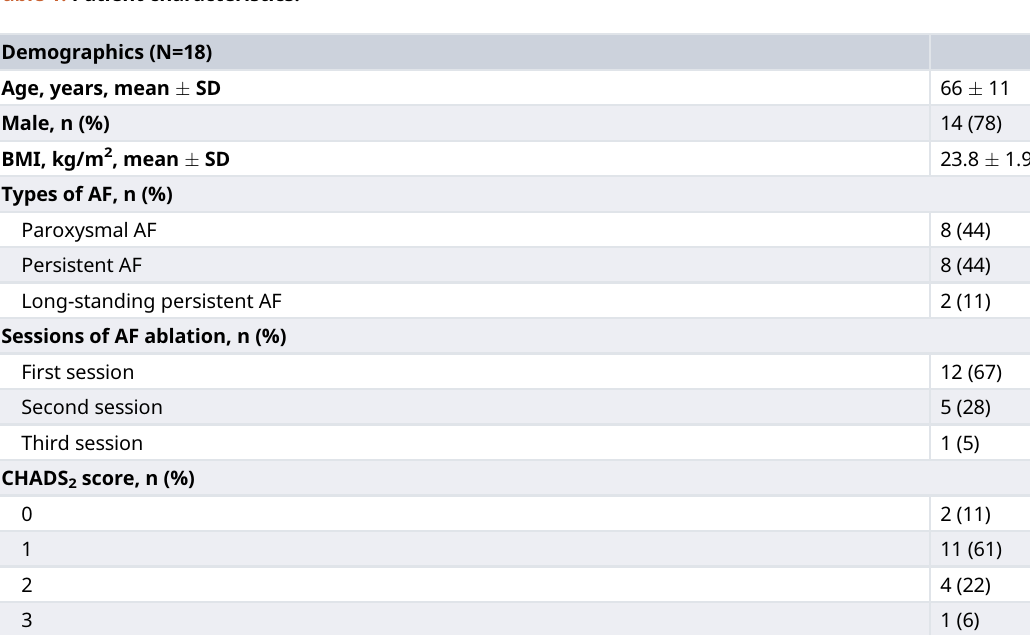
Table 1. Patient